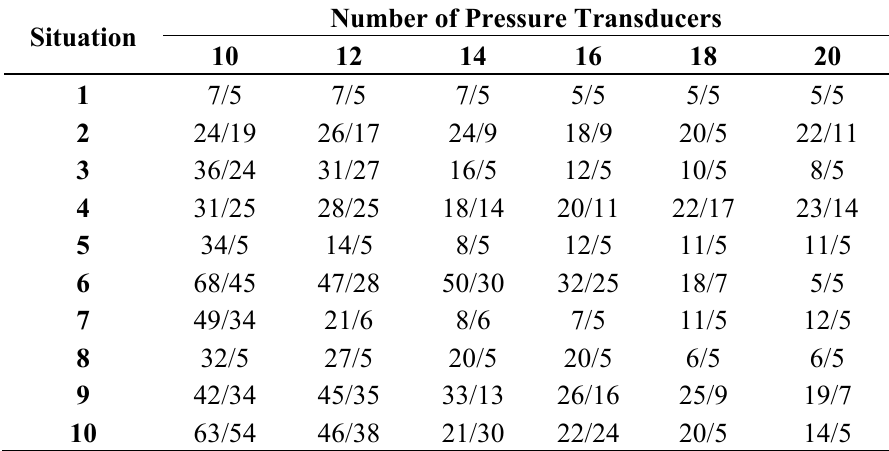
Table 5. Number of total leaky pipes in the first WDN (scenario 1/scenario